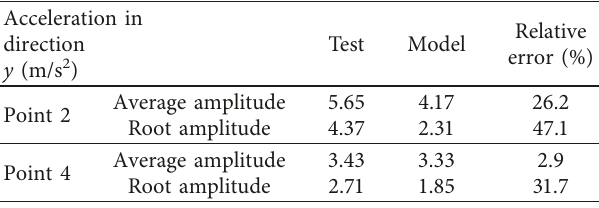
Table 7: Data comparison of test and model.